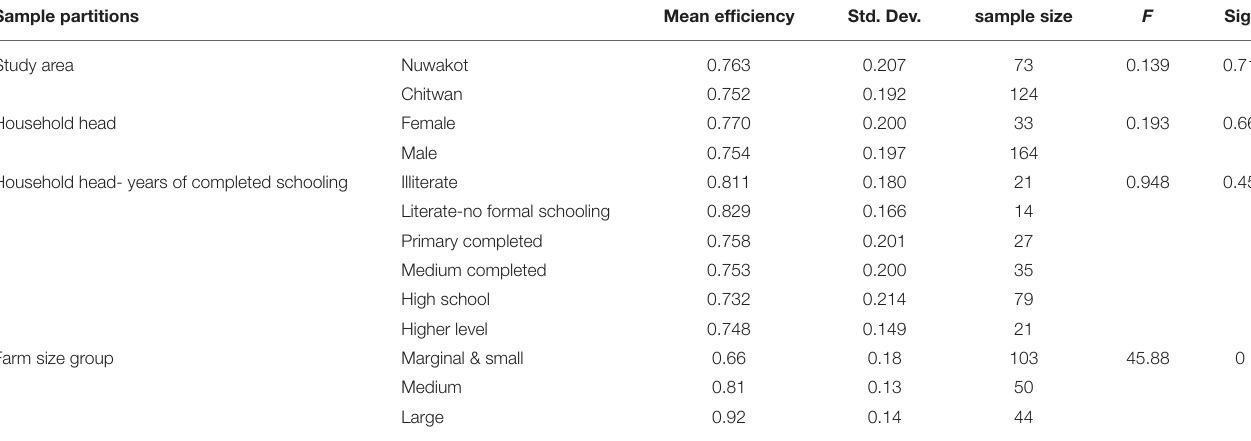
TABLE 12 | Distribution of efficiency scores across paddy farmers by various sample partitions, Nepal. Sample